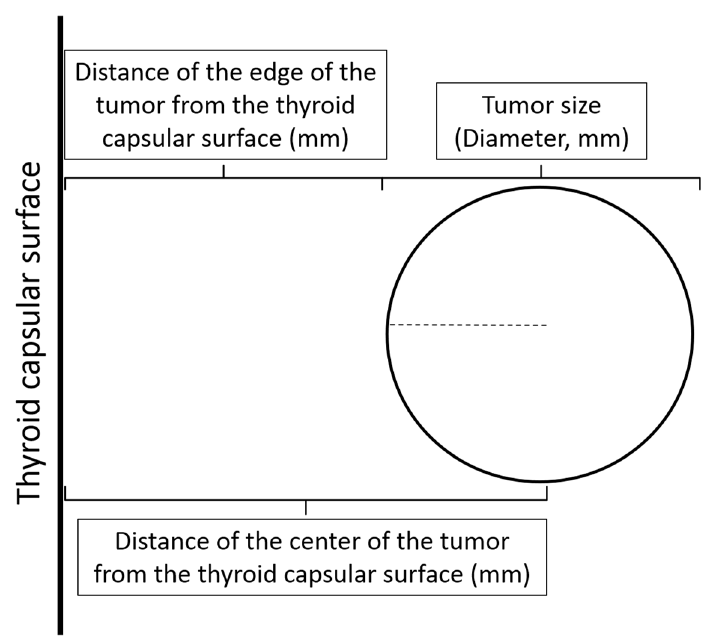
Figure 1. Distance of the center of the tumor from the thyroid surface. The distance of the center of the tumor from the thyroid surface is measured by adding the separate micrometric values of the distance of the edge of the tumor from the thyroid surface to the radius of the tumor (tumor diameter (mm)/2). Since the distance of the edge of the tumor from the thyroid surface in 12 of the 298 tumors was greater than 5 mm, it could not be accurately calculated (or estimated) on histology sections. These 12 mPTCs were therefore excluded from the analysis. Statistical analysis was thus conducted on 286 mPTCs from 257 patients, 29 of whom with multicentric